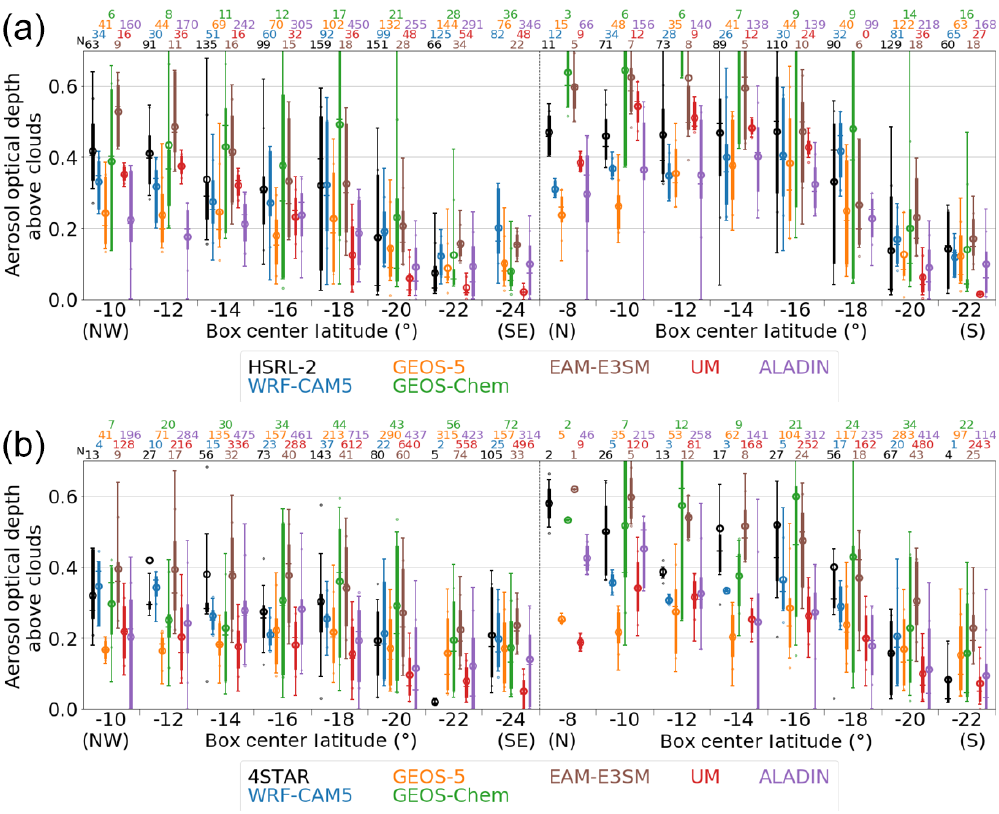
Figure 10. The aerosol optical depth above clouds (AC-AOD) compared between observations and models. Panel (a) compares to the HSRL-2 lidar observation from the ER2. Panel (b) compares to the 4STAR measurements made while the P3 aircraft was immediately above